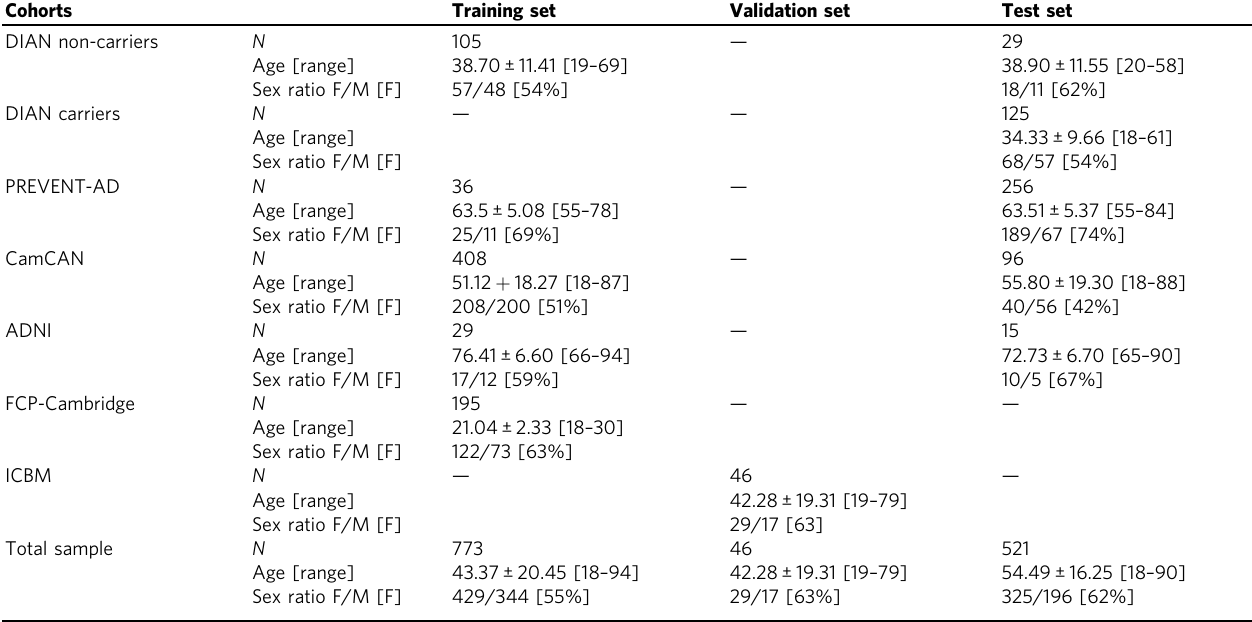
Table 1 Dataset characteristics.